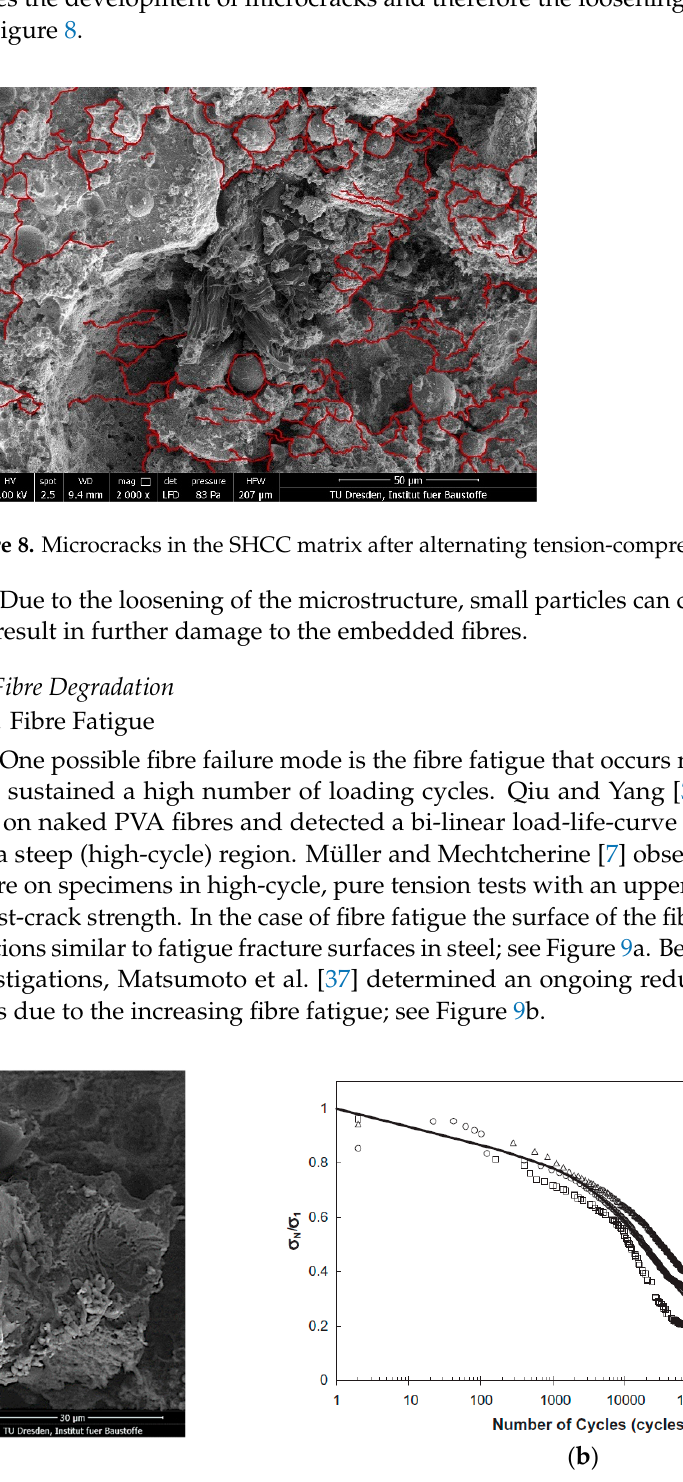
Figure 9. Fibre fatigue: ( a ) fracture surface of a PVA-fibre [7]; ( b ) bridging stress degradation due to fibre fatigue [37].